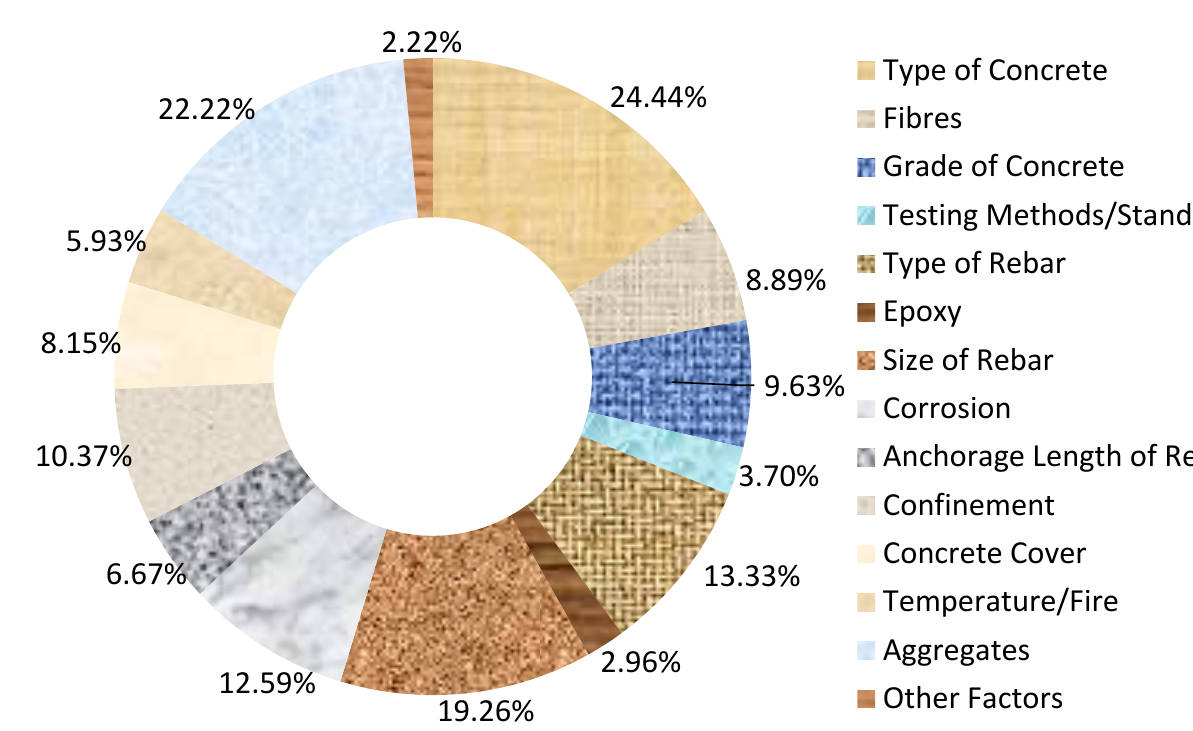
Figure 5. Contribution of literature on various parameters of bond strength.